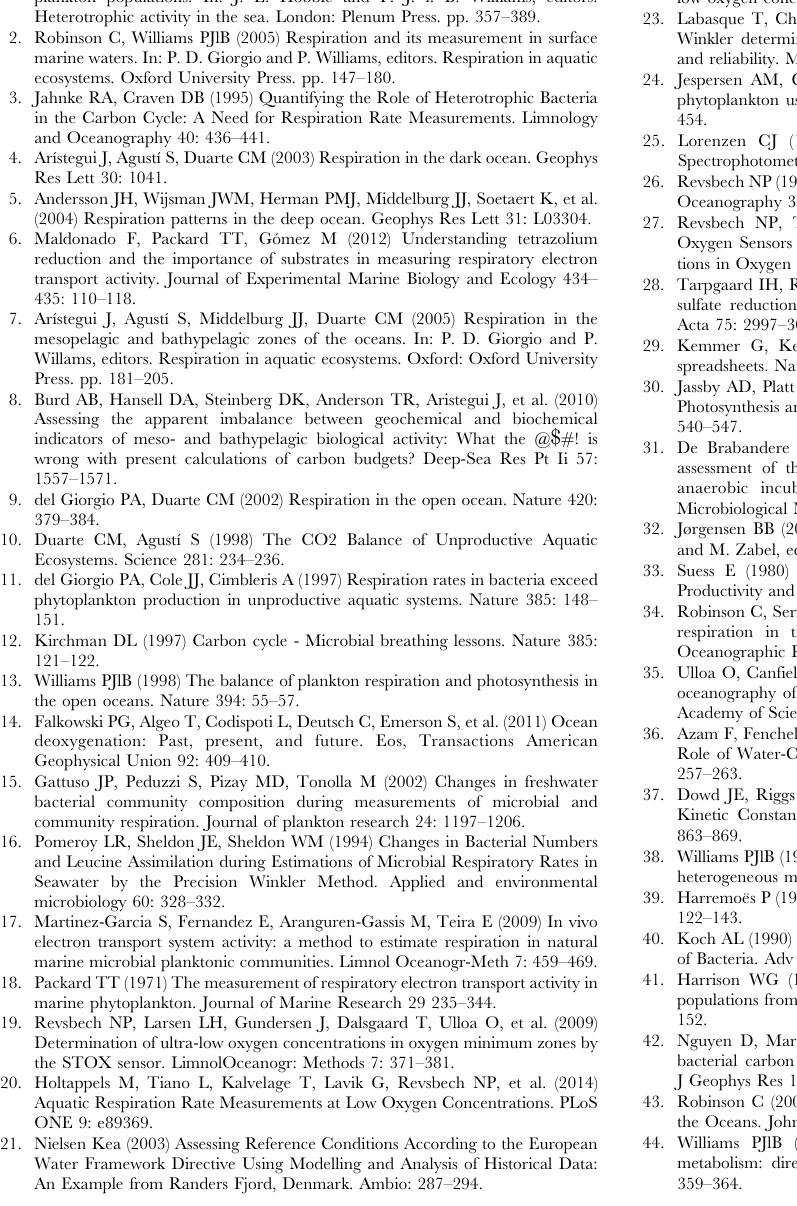
Figure S3 Comparison of kinetics models. Upper plot: respiration rate vs. oxygen concentration, a comparison of Michaelis-Menten and Jassby and Platt equations using the same fixed parameters. Lower plot: time evolution of the oxygen concentration in the incubation of one sample from Station 2, and comparison of Michaelis-Menten and Jassby and Platt equations, using as V max the respiration rate measured at 100% oxygen saturation (173 nmol L 2 1 h 2 1 ). (TIFF)